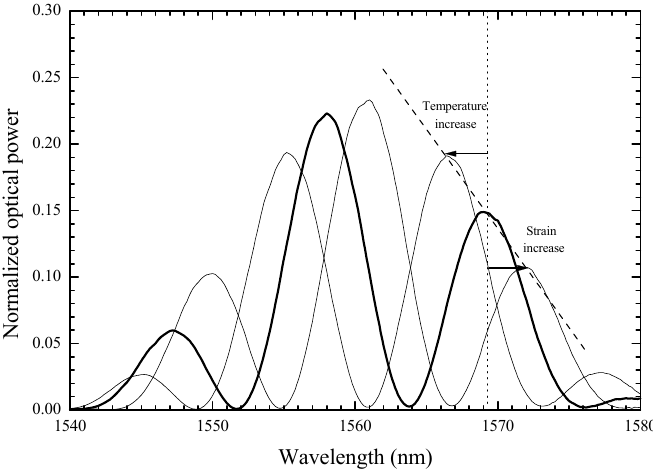
Figure 9. Spectral response of the concatenated FLMs, when strain is increased for constant temperature (spectral shift to longer wavelengths), .and when temperature is increased for constant strain (spectral shift to shorter wavelengths).